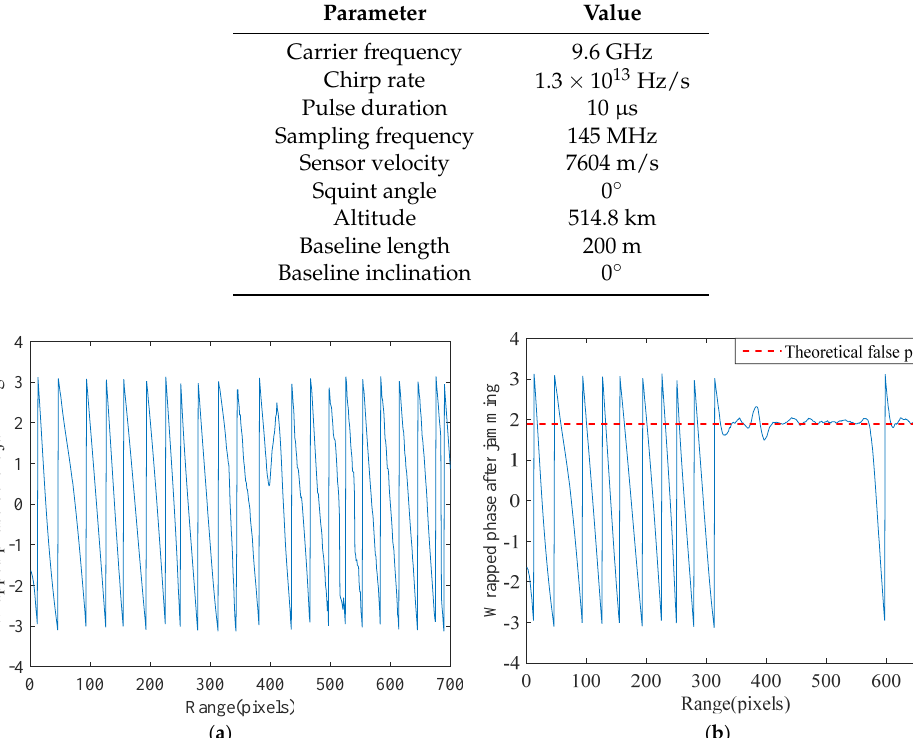
Figure 4. Detailed steps of the proposed SAR deception detection method. To differentiate the deceptive targets from real ones, co ‐ registration of corresponding SAR images is first applied and the interferogram with deceptive jamming is derived. Secondly, phase filtering is carried out to effectively improve the detection accuracy. Then, frequency detection in the range direction is employed to extract the false phase in the interferogram. The false scene in the SAR image is obtained ultimately according to the deduced 0–1 valued mask matrix. 4.1. SAR Image Co ‐ Registration Generally, SAR image registration consists of geometric registration and image co ‐ registration. The geometric registration based on imaging geometry and orbit parameters is not necessary unless there is obvious offset or angulation between master and slave image. The co ‐ registration of InSAR images, including coarse co ‐ registration and fine co ‐ registration, is one of the key steps of interferometric processing [24]. Normally, the registration offsets in coarse or fine co ‐ registration